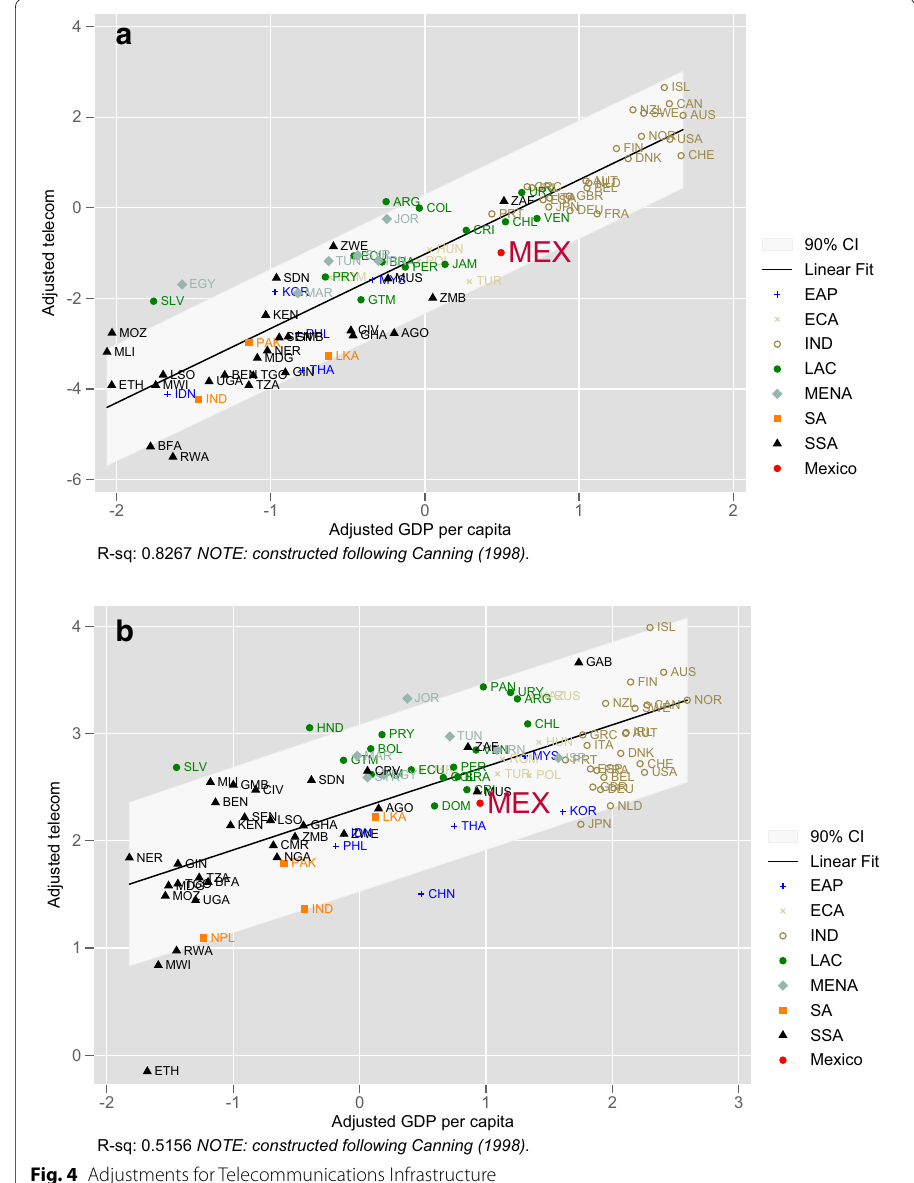
Fig. 4 Adjustments for Telecommunications